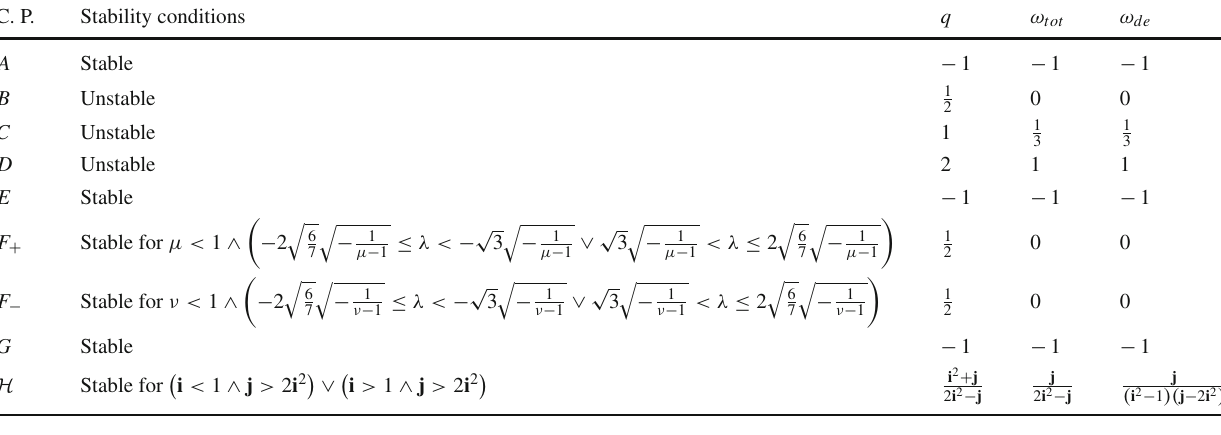
Table 3 Cosmological solutions of critical points